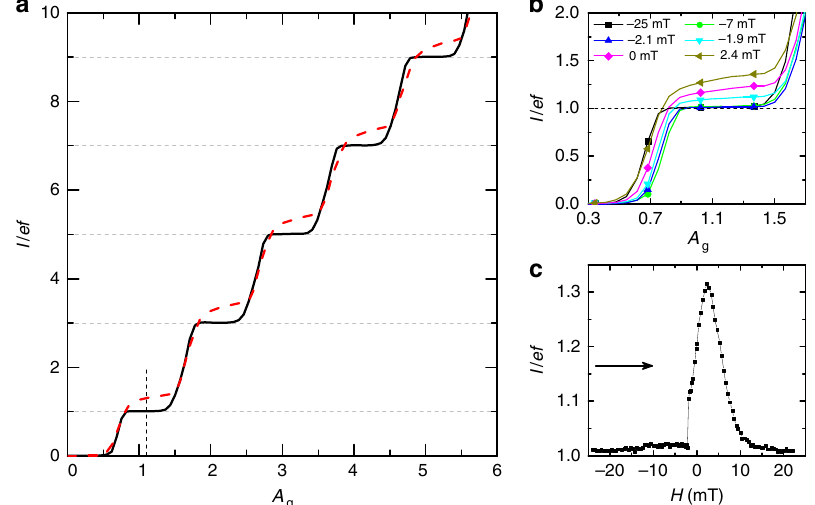
Figure 3 | Turnstile current driven by an a.c. gate. ( a ) The pumping current I normalized by ef at the operating frequency f ¼ 5MHz, the bias voltage 0.5 versus the normalized gate amplitude A g at applied field H ¼ 2.4mT ( B ¼ 0) (red dashed curve) and at V bias ¼ 100 m V, and at the gate offset n 0 g ¼ H ¼ (cid:3) 25mT (black solid curve). The horizontal dashed lines correspond to the expected current quantization I ¼ nef ; ( b ) the zoom up of the first plateau at several applied field values between (cid:3) 25 and 2.4mT; ( c ) the evolution of the current along the vertical dashed line in a versus the field H varying from (cid:3) 25 to 25mT; the sweep direction is shown by the horizontal arrow. In the further measurements we fixed the amplitude to the value shown by the vertical dashed line in a . The experimental uncertainty has been estimated from the noise of the amplifiers as B 10fA, corresponding to 0.0125 ef at 5MHz (not